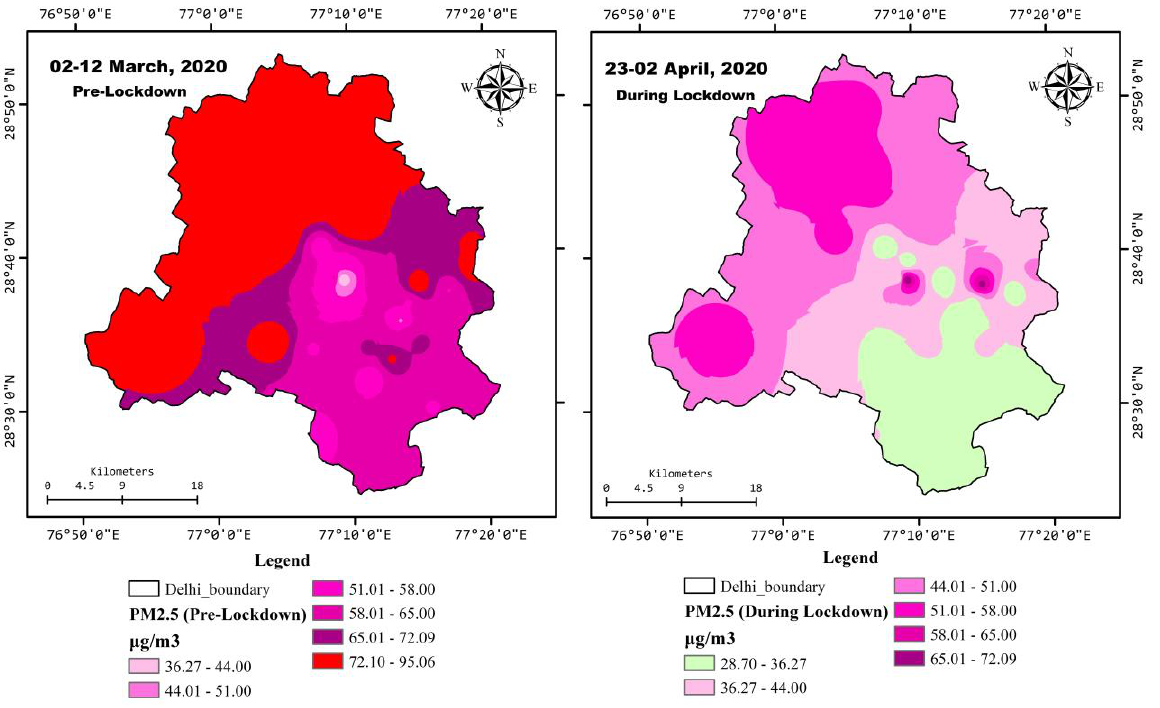
Figure 5. Distribution of PM 2.5 concentrations before and during the lockdown. The same classes have been provided with the same colour scheme for easy visualization of assessing the changes in the PM 2.5 before and during the lockdown. It must be noted that pre-lockdown period PM 2.5 ranges from 36.27 to 95.06 μg/m 3 . In contrast, during the lockdown, it went down and ranged from 28.70 to 72.09 μg/m 3 .